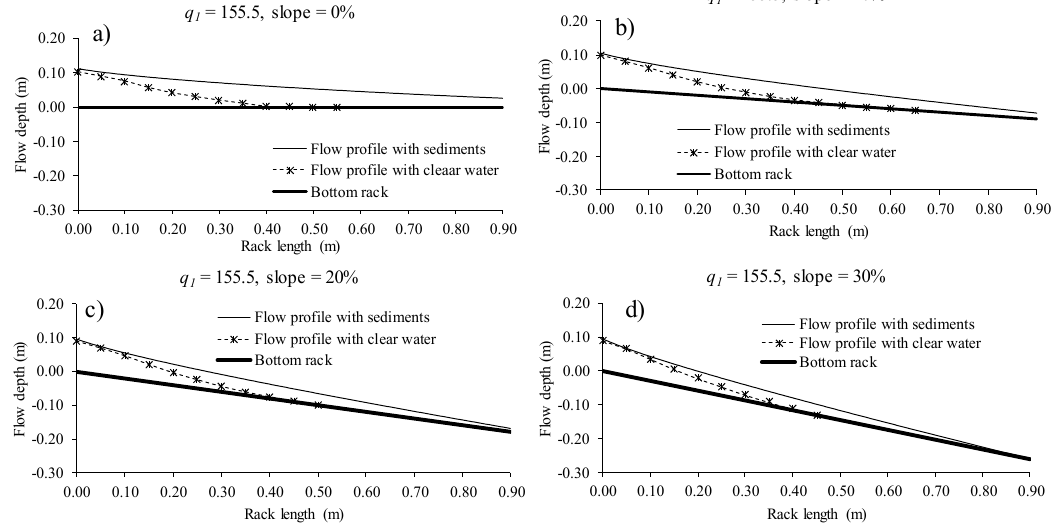
Figure 12. Water profiles over the rack measured in the laboratory and calculated for q 1 = 155.5 l/s/m and slopes ( a ) 0%; ( b ) 10%; ( c ) 20%; and ( d ) 30%.